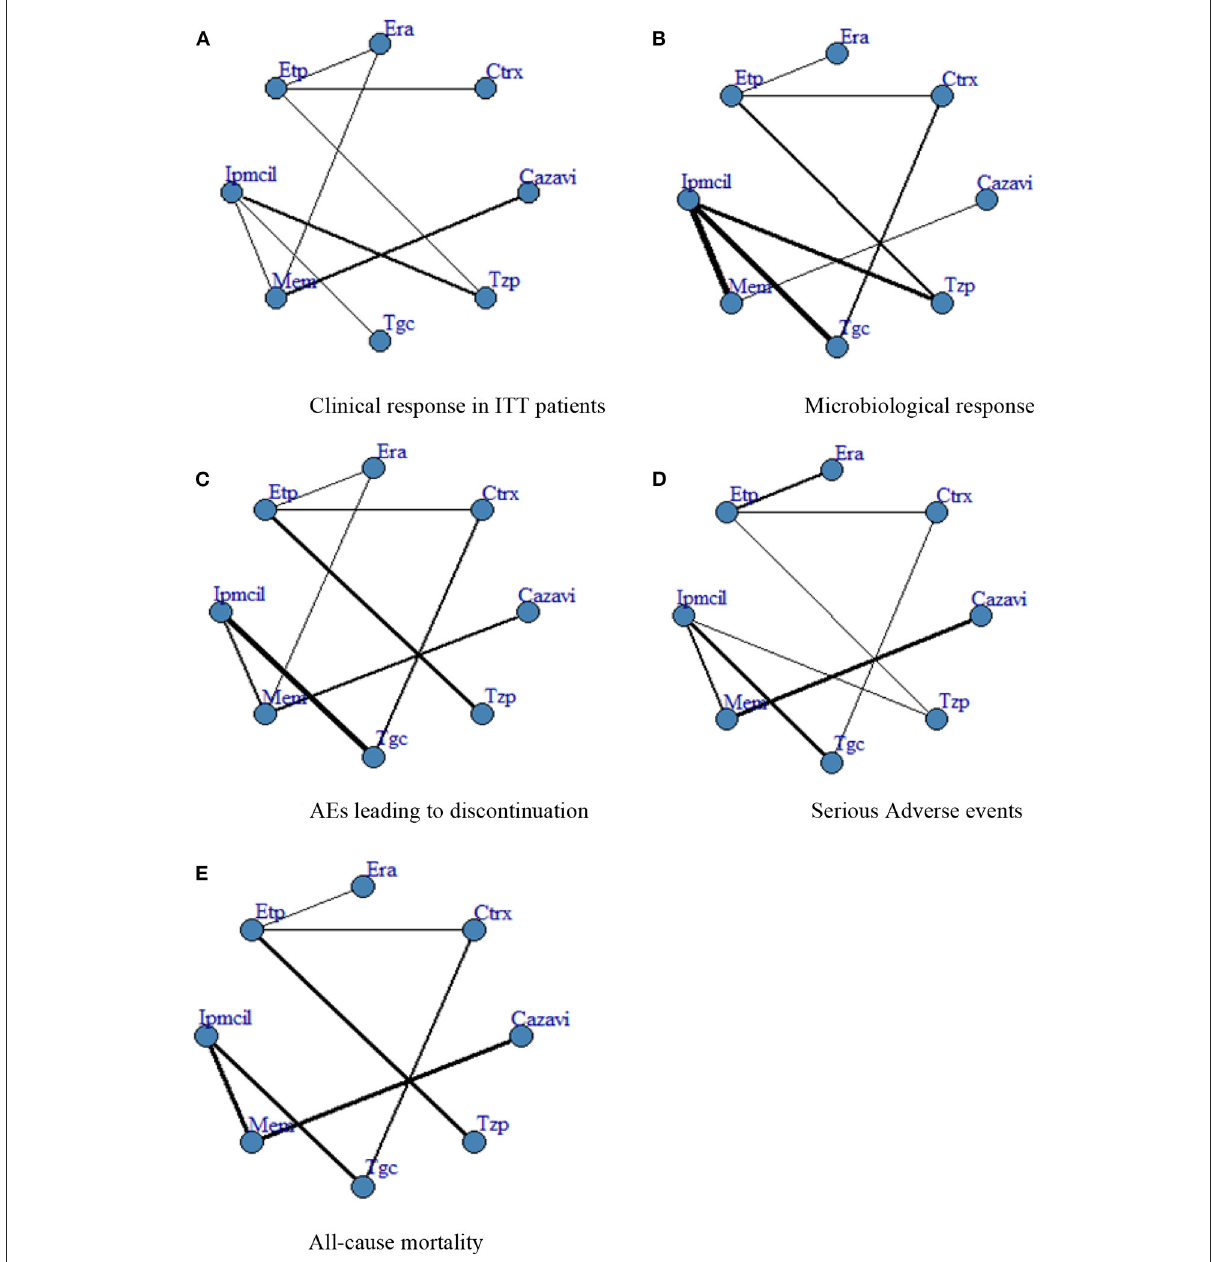
FIGURE3 (A–E) Network plot. ITT, intention-to-treat; Era, eravacycline; Etp, ertapenem; Mem, meropenem; Tgc, tigecycline; Cazavi, ceftazidime/avibactam + metronidazole; Tzp, piperacillin/tazobactam; Ctrx, ceftriaxone + metronidazole; Ipmcil, imipenem/cilastatin.